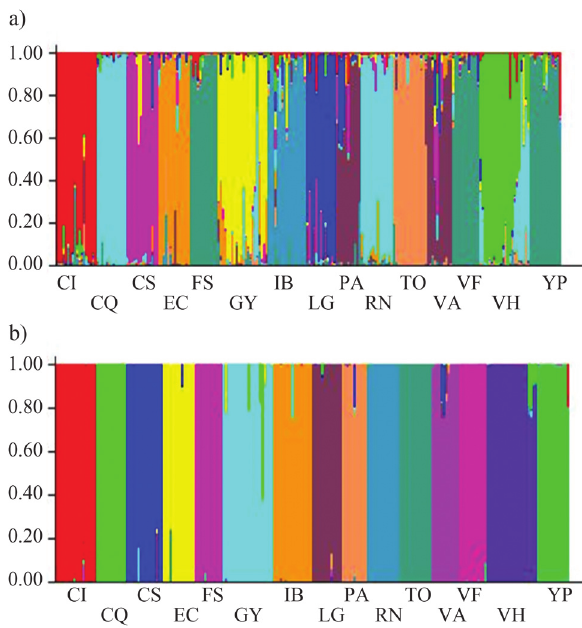
Figure 3 - Clustering of individuals by STRUCTURE. Each individual is represented by a vertical bar that is partitioned into colored segments that represent the individual’s estimated membership fractions. Same color in different individuals indicates that they belong to the same cluster. a) K = 11, estimated with no prior distribution of populations; b) K = 15, esti- mated with LOCPRIOR option. Population codes are given in Table